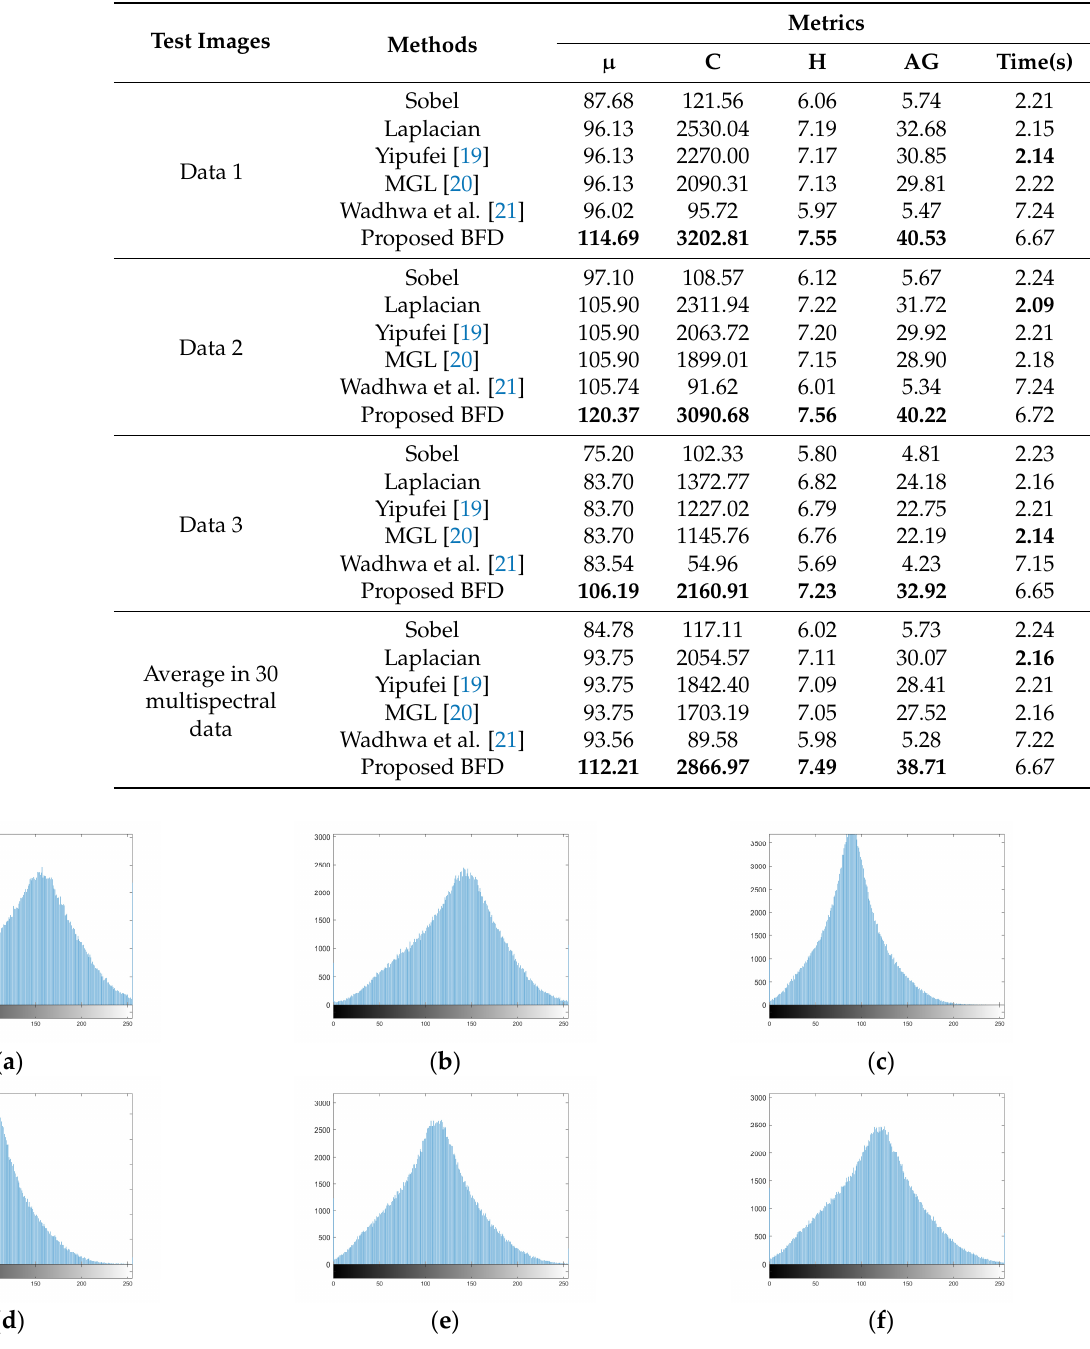
Table 6. The quantitative results of the six differential methods with the proposed IDCP algorithm.